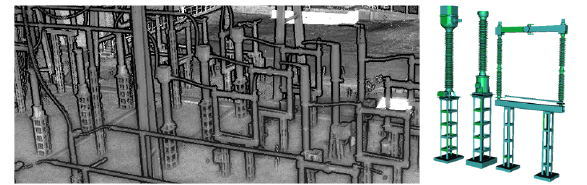
Figure 2. On left, a 3D point cloud of an electrical substation; on right, three CAD models expected to be found in the scene.